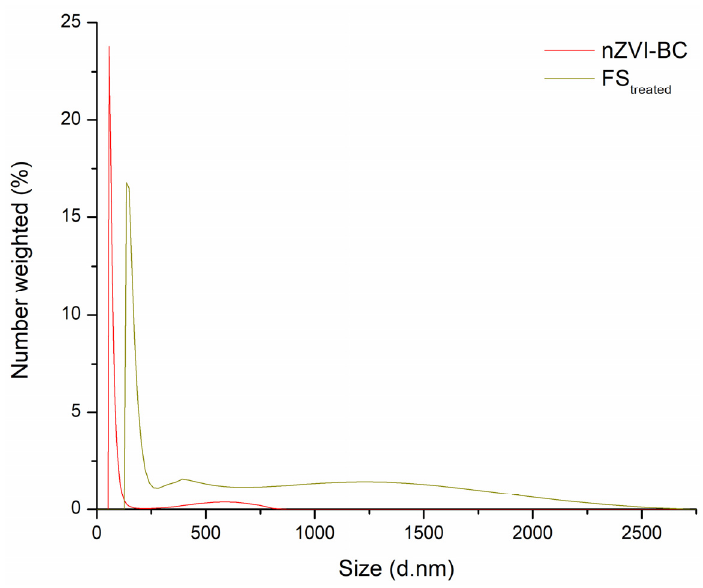
Figure 3. Particle size distribution curve for nZVI-BC and FS treated.